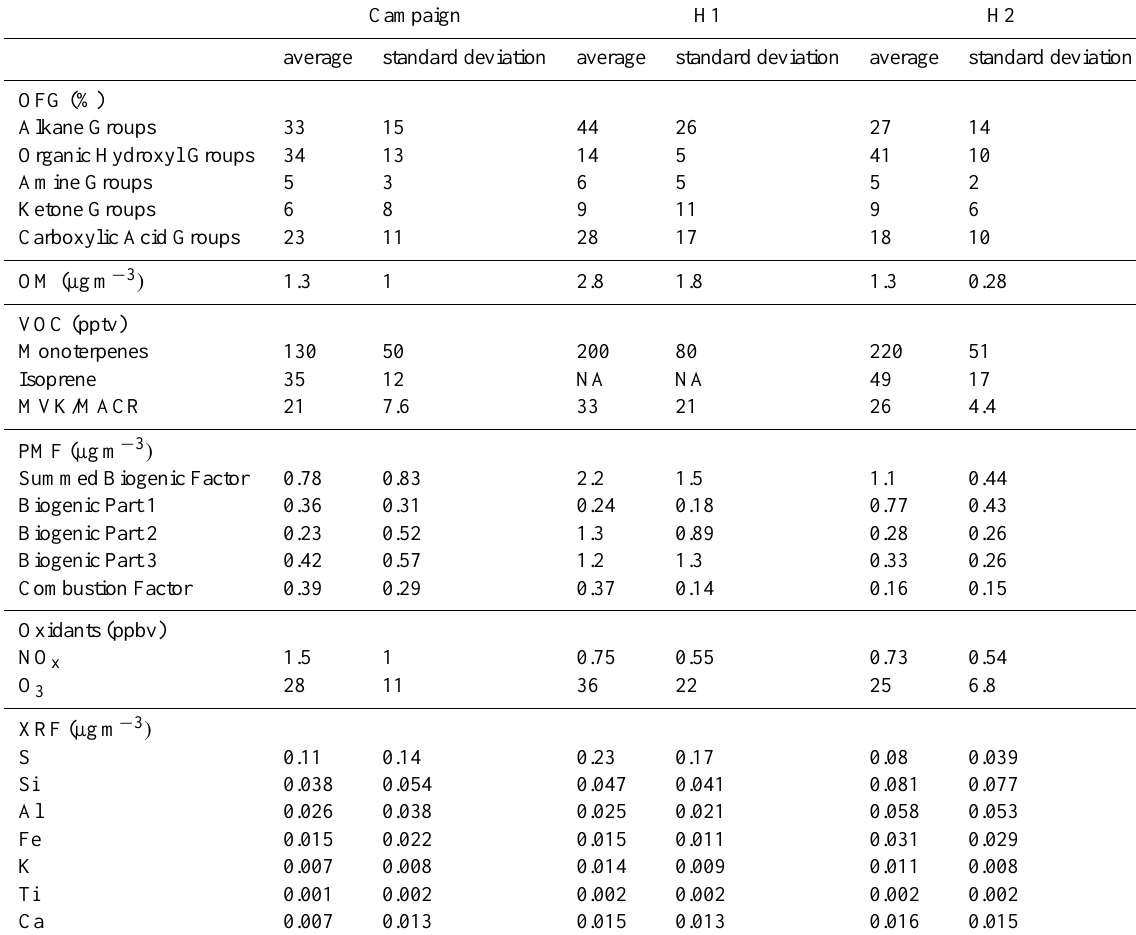
Table 1. Time weighted Mean and Standard Deviation of Measured OM, OFGs, VOCs, Oxidants, PMF Factors and Elemental Concentrations for the Campaign and for Periods H1 and